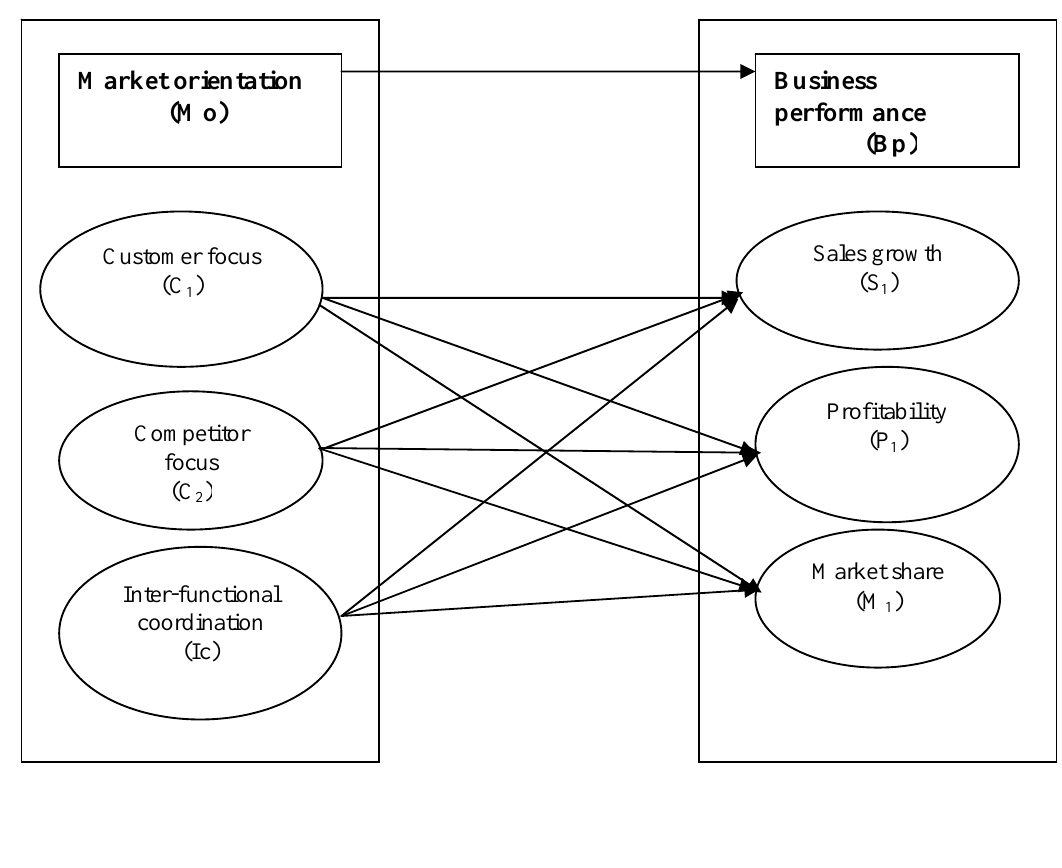
Figure 1: Operational Conceptual Framework